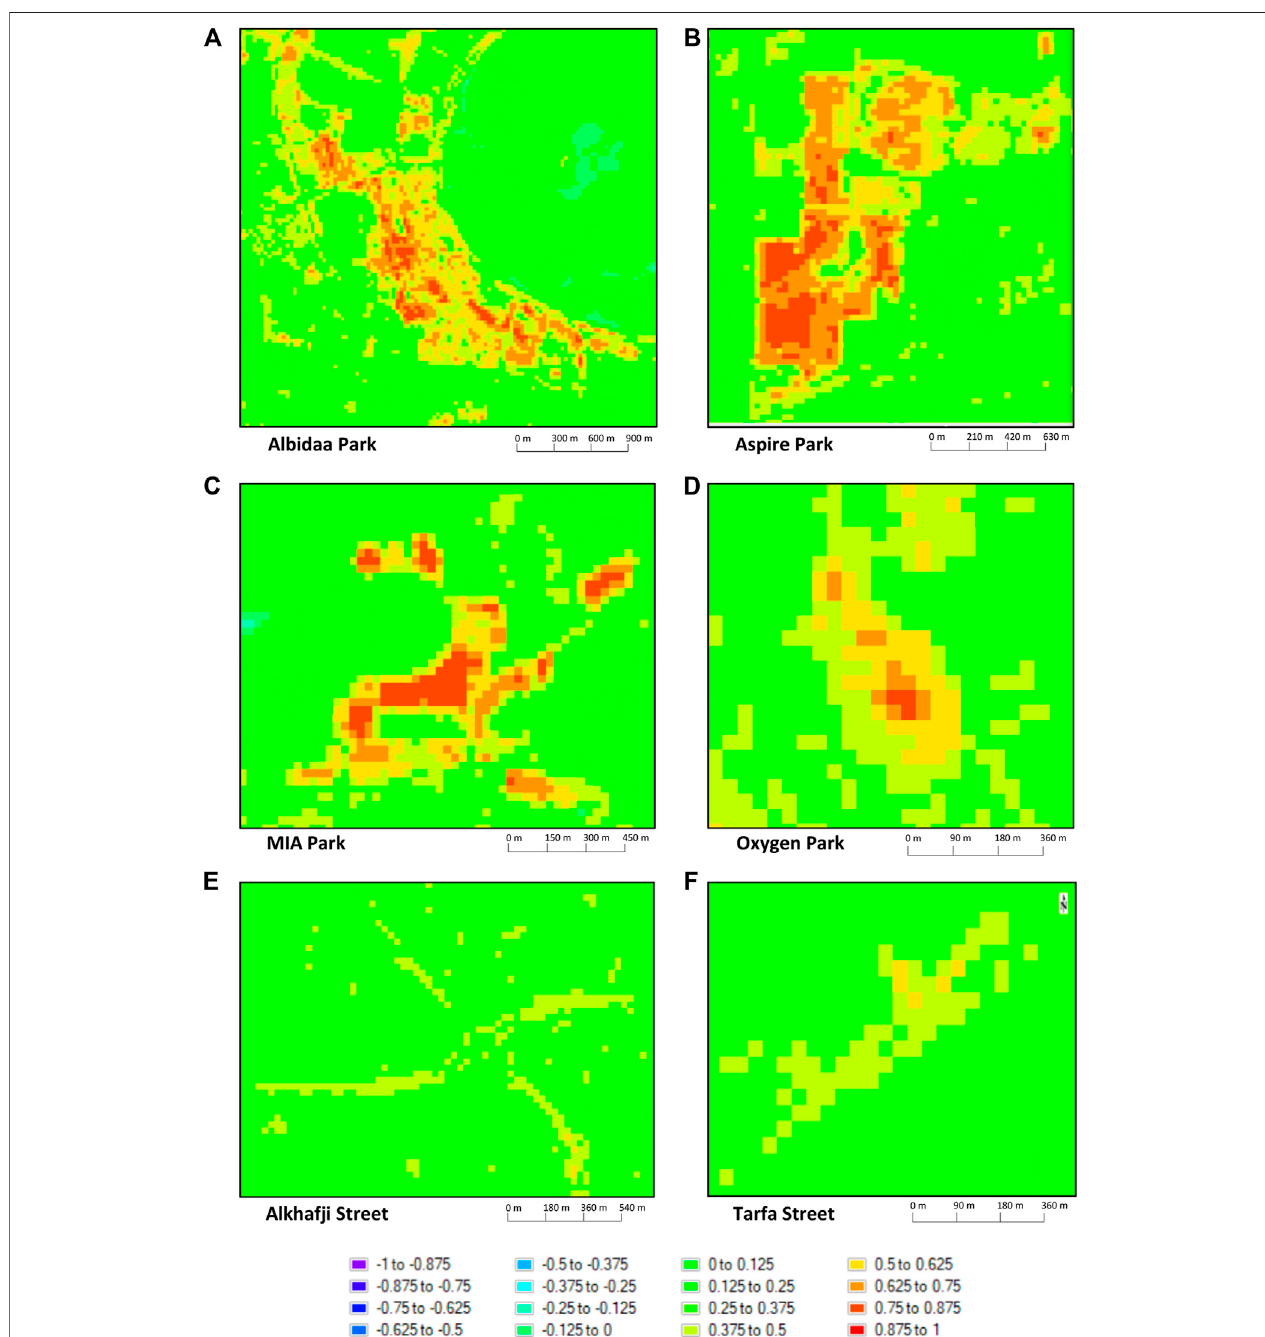
FIGURE 6 | NDVI map of the selected land-use types based on the images acquired from Landsat 8 OLI on May 23, 2020.